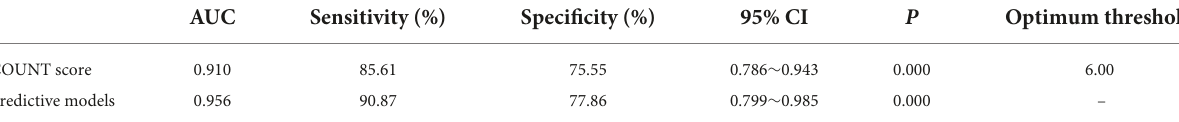
TABLE 4 Efficacy of indicators to predict the prognosis of patients with human immunodeficiency virus (HIV) infection-associated lymphoma.